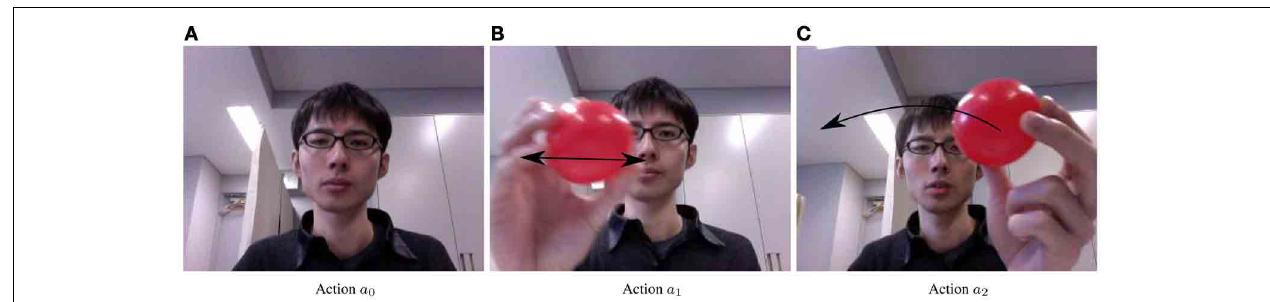
FIGURE 5 | Actions made by experimenter. (A) Action a 0 . (B) Action a 1 . (C) Action a 2 .